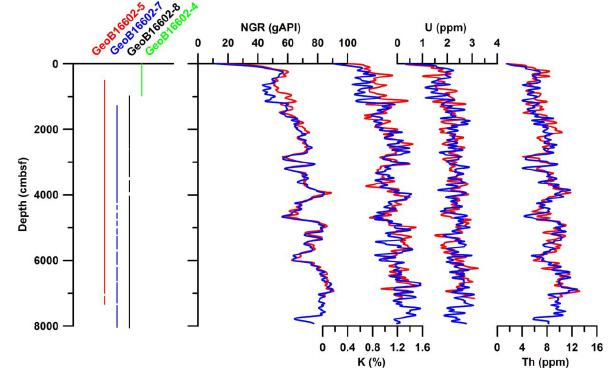
Fig. 7. Core recovery with a gravity core (GeoB16602-4) and Figure 7. Core recovery with a gravity core (GeoB16602-4) and three separate MeBo 3 three separate MeBo deployments (GeoB16602-5, GeoB16602-7, deployments (GeoB16602-5, GeoB16602-7, GeoB16602-8) and bore hole logging results of 4 GeoB16602-8) and borehole logging results of MeBo deployments MeBo deployments GeoB16602-5 and GeoB16602-7 at the continental slope of the South 5 GeoB16602-5 and GeoB16602-7 at the continental slope of the China Sea in 950 m water depth. 6 South China Sea at 950m water